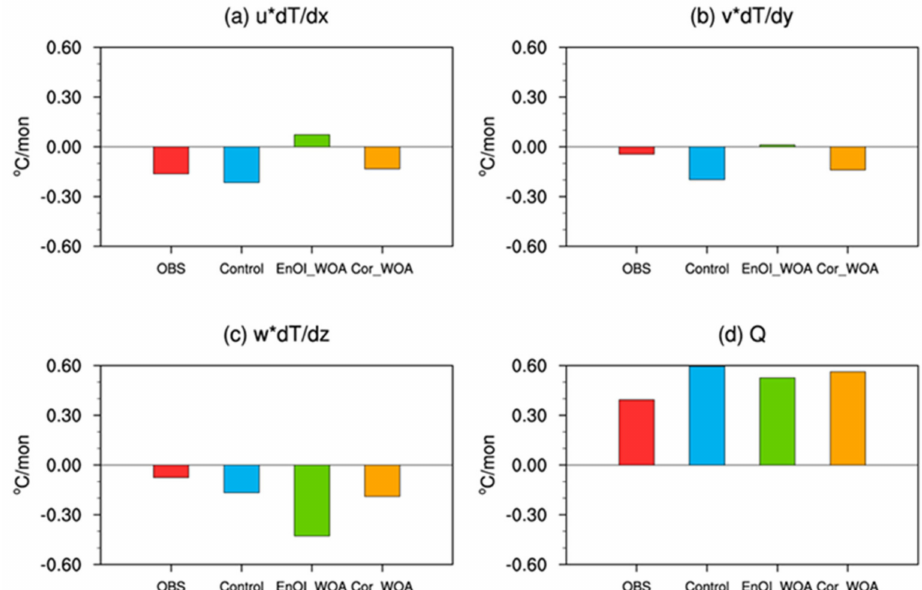
Figure 8. The average of the heat budget in the western tropical Pacific ( − 5–5 ◦ N, 160–190 ◦ E): ( a ) u*dT/dx; ( b ) v*dT/dy; ( c ) w*dT/dz; ( d ) Q ; red, OBS; blue, Control; green, EnOI_WOA; orange, Cor_WOA.